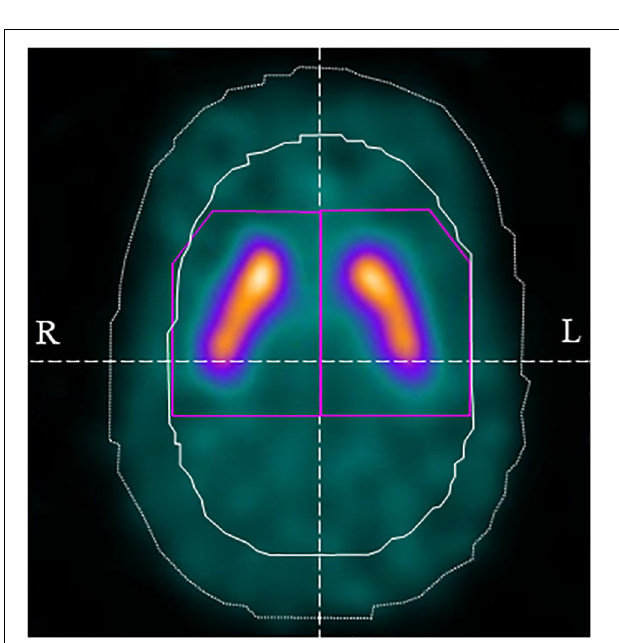
FIGURE 2 | Volume of interest (VOI) setting using DaTView. The purple line shows the striatum VOI and the white solid line shows the background (non-specific)